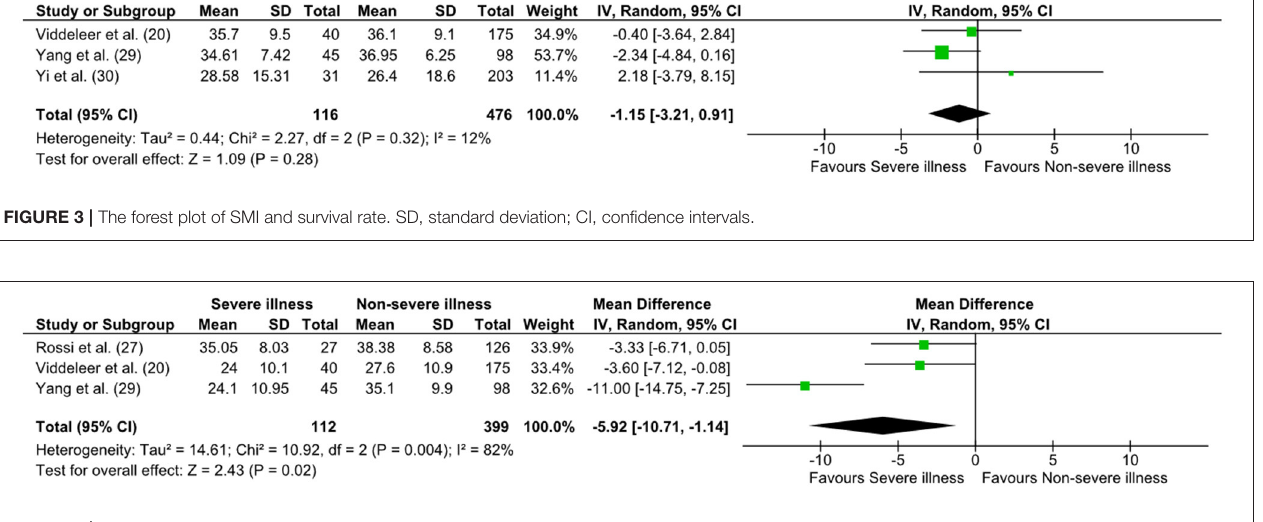
FIGURE 4 | The forest plot of muscle density status and survival rate. SD, standard deviation; CI, confidence intervals; HU, Hounsfield units.